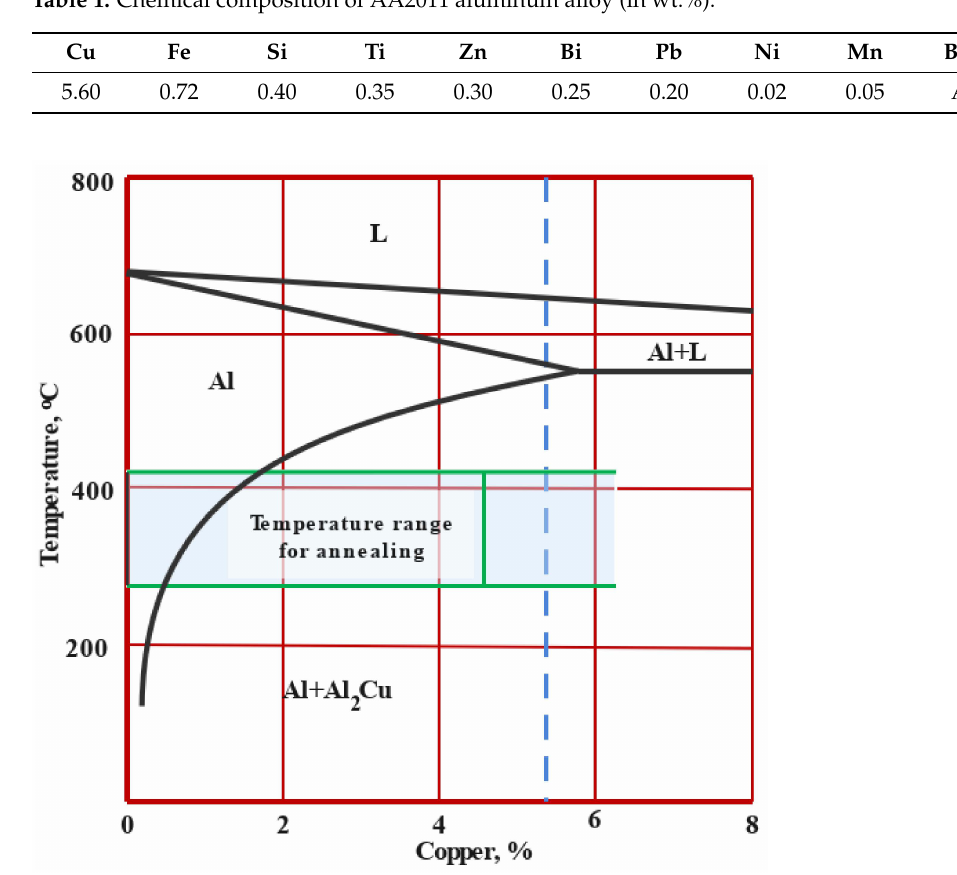
Figure 1. A sketch for the Cu-rich portion of the Al–Cu binary phase diagram with the annealing temperature range indicated.